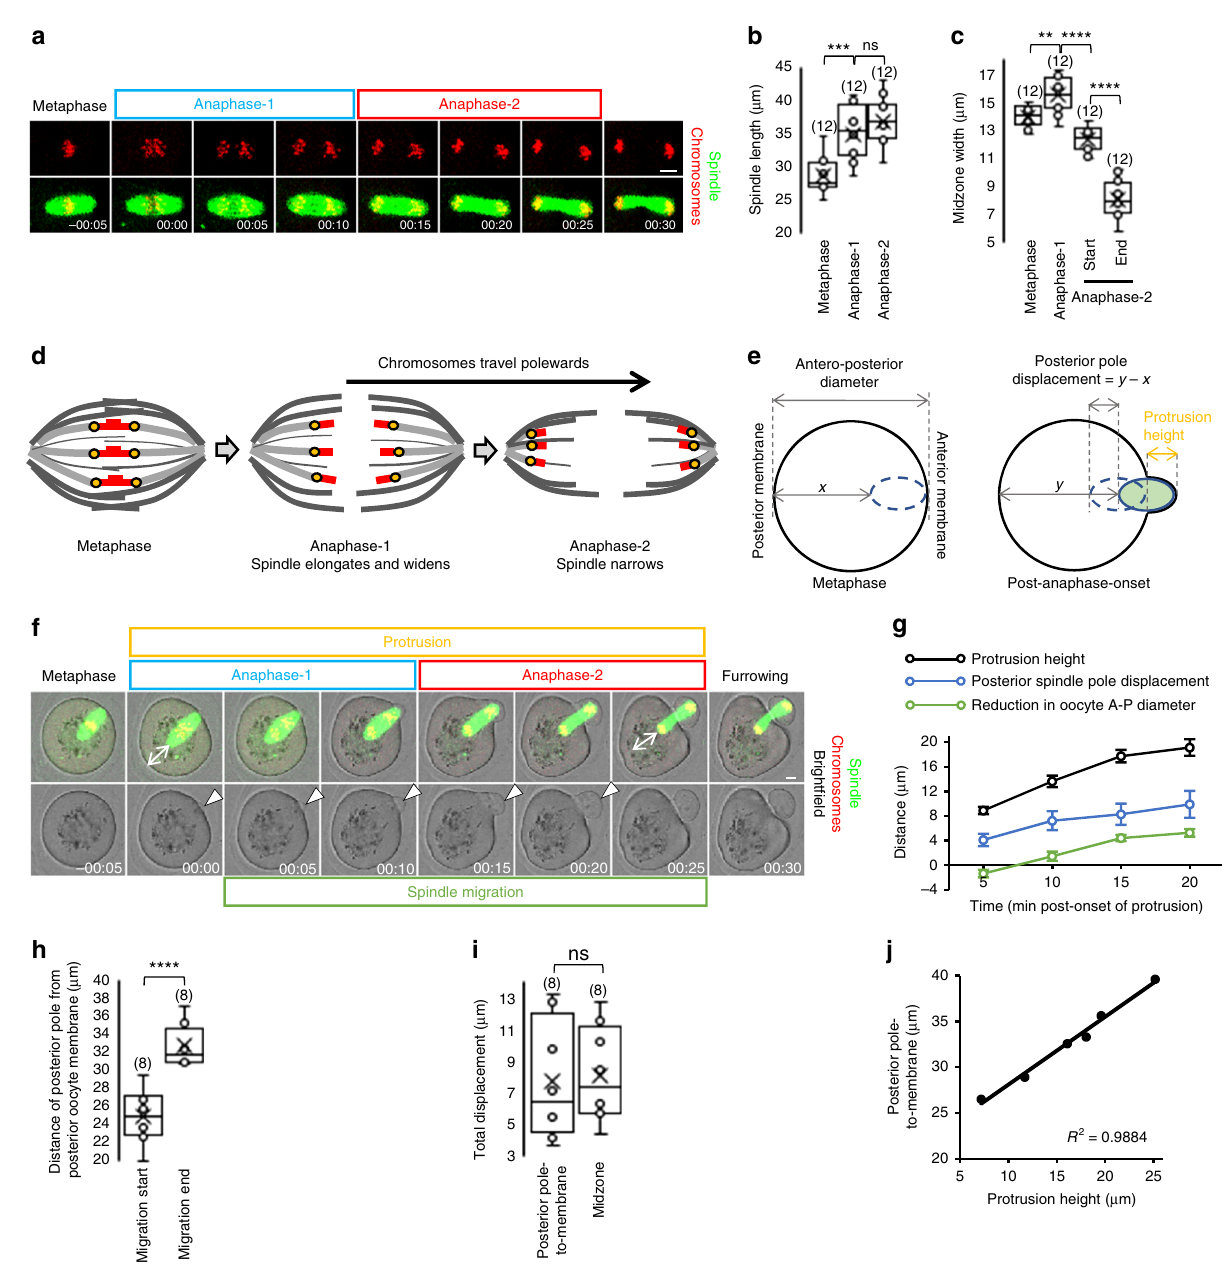
Fig. 1 Spindle migration following anaphase-onset induces protrusion. a – c Stages of anaphase ( a ) and quanti fi cation of stage-speci fi c spindle dimensions ( b , c ) derived from live oocytes with fl uorescently labelled spindles and chromosomes. One-way ANOVA used for statistical analysis. d , e Schematics depicting stages of anaphase ( d ) and measurements ( e ). f Example of protrusion (white arrowheads) and spindle migration into the membrane occurring after anaphase-onset in a live oocyte (see Supplementary Movie 3). g – i Quanti fi cation of protrusion height, spindle displacement and oocyte dimensions ( g , n = 12, error bars are mean ± SEM) (see e ); total posterior pole displacement ( h ) and comparison with total midzone displacement ( i ) between anaphase-onset and anaphase-completion. Two-tailed Student ’ s t test used for statistical analysis. j Correlation between spindle migration and protrusion height ( n = 12). Times in panels are hours:minutes relative to anaphase-onset. Scale bars, 10 µ m. Box plots depict median (horizontal line), mean (crosses), 25th and 75th percentiles (boxes) and 5th and 95th percentiles (whiskers). Oocyte numbers are shown in parenthesis. P values represented as ** P < 0.01, *** P < 0.001 and **** P < 0.0001, ns denoted P >